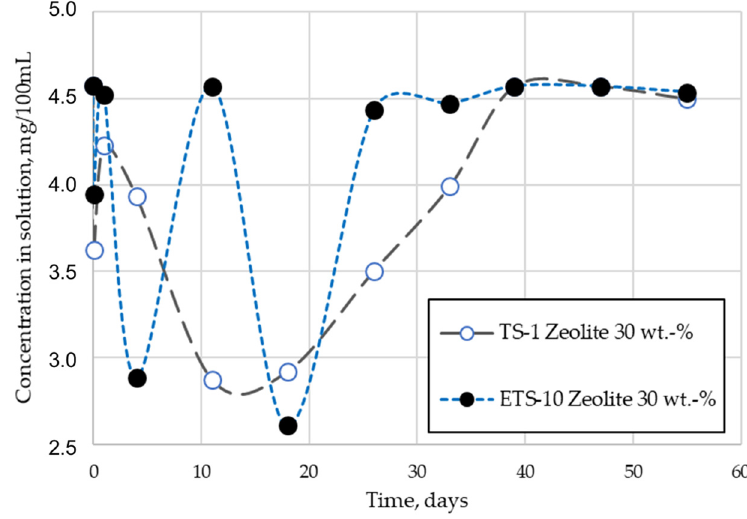
Figure 5. Matrimid membrane loaded with 30 wt. % TS-1 zeolite and 30 wt. % ETS-10